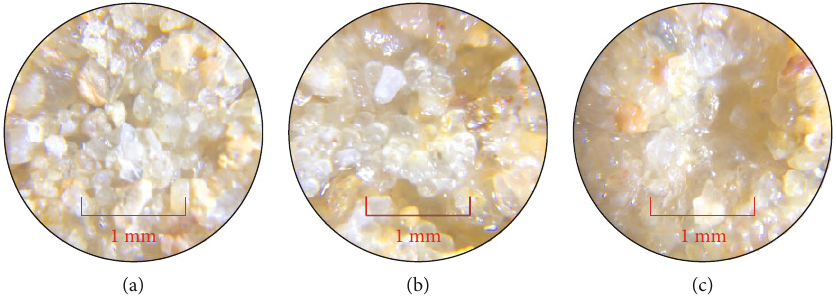
Figure 16: The digital microscope image of PU-sand mixture: (a) without immersion; (b) 0 h after removing from water; (c) 12 h after removing from